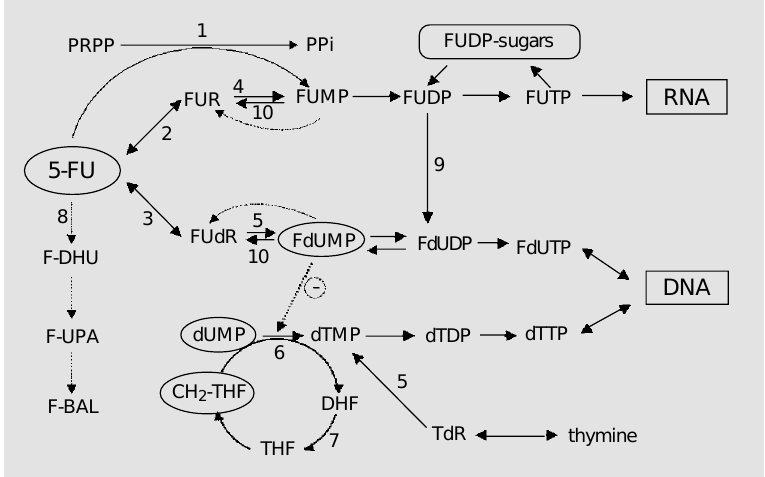
9FUDP-sugars RNA DNA Figure 1. Metabolic pathways and mechanism of action of 5-fluorouracil (5-FU). Enzymes catalyzing these reactions are 1 , orotate phosphoribosyltransferase; 2 , uridine phosphoryl- ase; 3 , thymidine phosphorylase; 4 , uridine kinase; 5 , thymidine kinase; 6 , thymidylate synthase; 7 , dihydrofolate reductase; 8 , dihydropyrimidine dehydrogenase; 9 , ribonucle- otide reductase; 10 , 5’-nucleotidases and phosphatases. FUMP, FUDP, FUTP: fluorouridine -5’-mono-, di-, and triphosphate, respectively; FdUMP, FdUDP, FdUTP: fluorodeoxyuridine- 5’-mono-, di-, and triphosphate, respectively; dUMP: deoxyuridine-5’-monophosphate; dTMP, dTDP, dTTP: deoxythymidine-5’-mono-, di-, and triphosphate, respectively; PRPP: 5- phosphoribosyl-1-pyrophosphate; FUR: fluorouridine; FUdR: fluorodeoxyuridine; F-BAL: a -fluoro-ß-alanine; F-UPA: fluoroureidopropionate; F-DHU: 5-fluorodihydrouracil; DHF: dihydrofolate; THF: tetrahydrofolate; TdR: thymidine; PPi: pyrophosphate. Modified from Ref. 61.